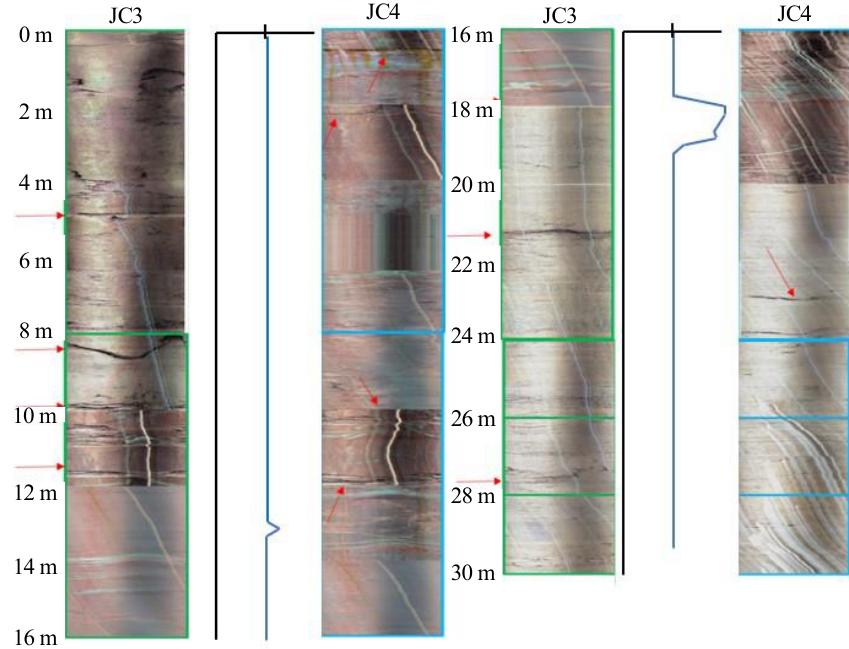
Figure 18. Comparison of borehole images and acoustic velocity measurement (161 m).